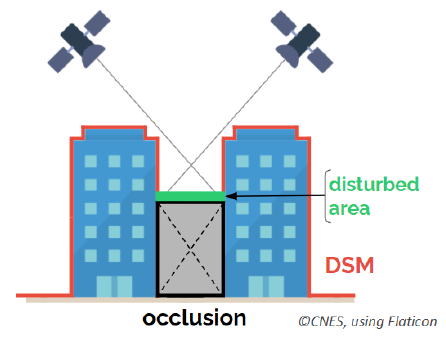
Figure 7. Occlusion illustration.